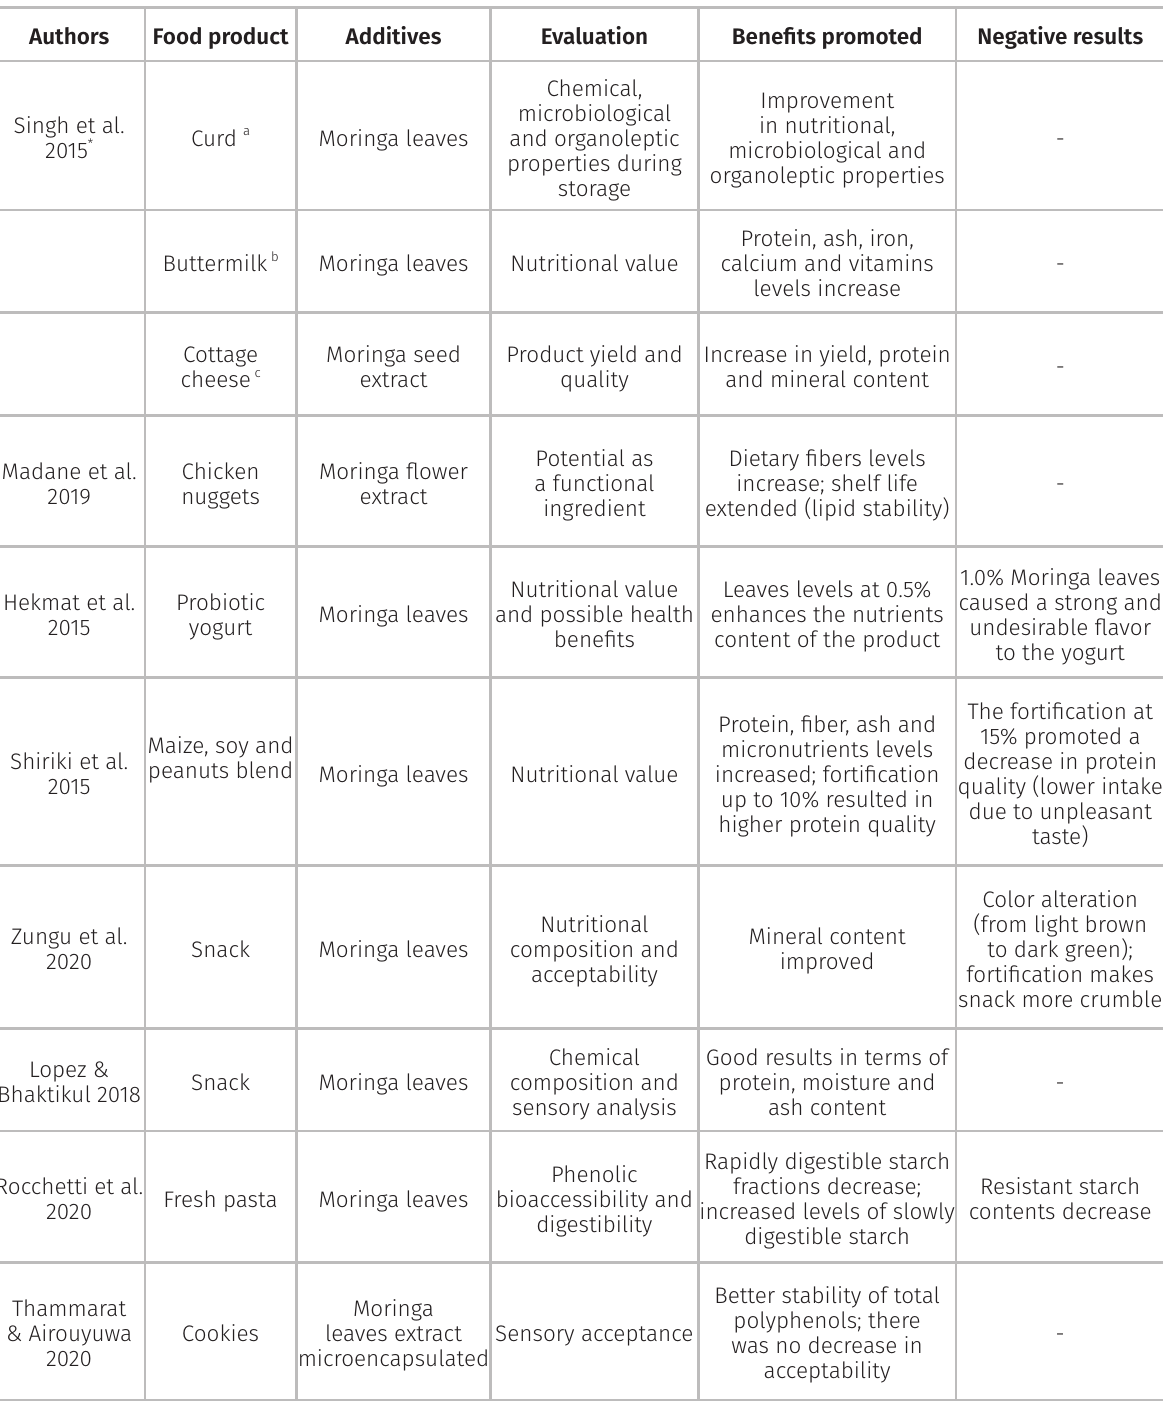
Table V. Summary of nutritional and functional aspects promoted by the addition of Moringa oleifera in food